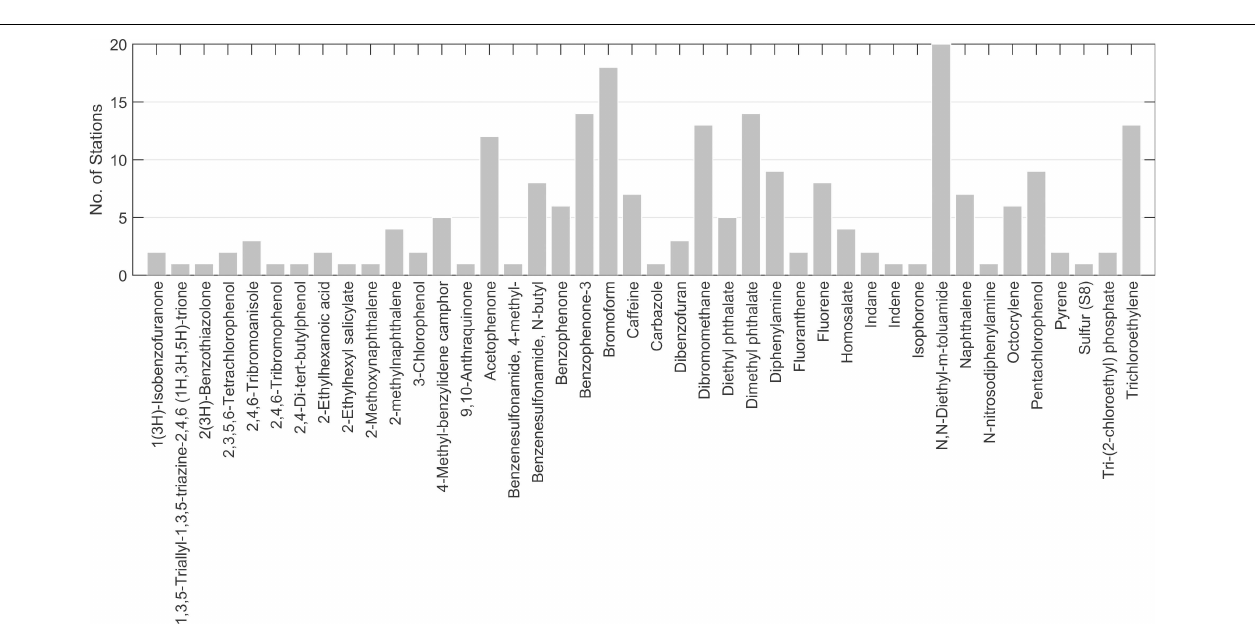
FIGURE 6 | Total number of chemicals of interest identified at each station using the GCMS screen. Green bars = stations with ≤ 5 contaminants. Red bar = > 20 contaminants.